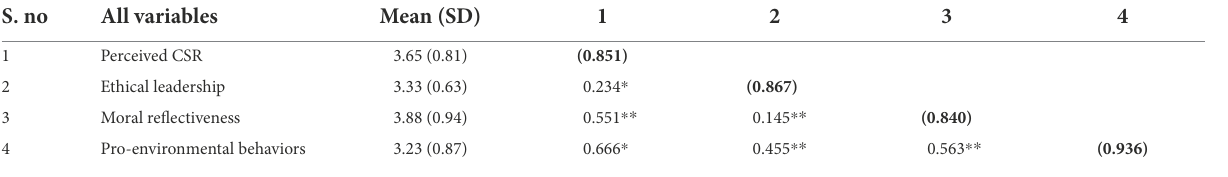
TABLE 3 Mean, standard deviation, and